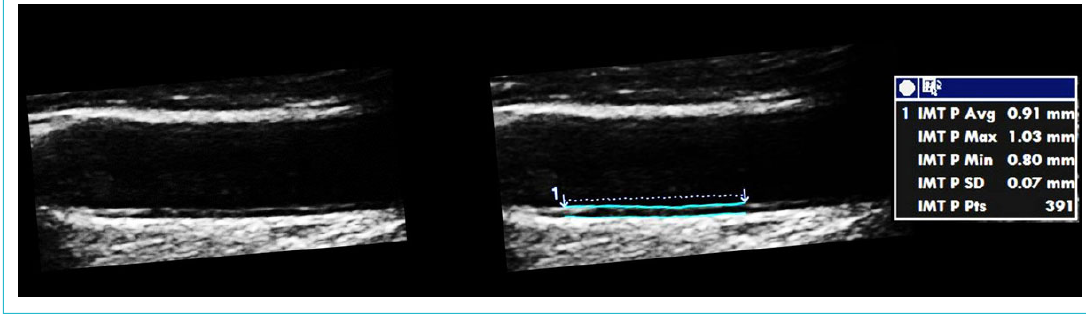
Figure 3: Intima-media thickness (IMT measurement) according to the Mannheim consensus [ 15 ]. The carotid artery IMT should be par- allel to the ultrasound beam and the measurement should be performed in the distal part of the common artery using a diastolic frame and ex- cluding carotid plaque defined by (1) thickness >1.5 mm; (2) lumen encroaching >0.5 mm; (3, 4) >50% of the surrounding IMT value. The IMT value should be derived from a length of 10 mm with 150